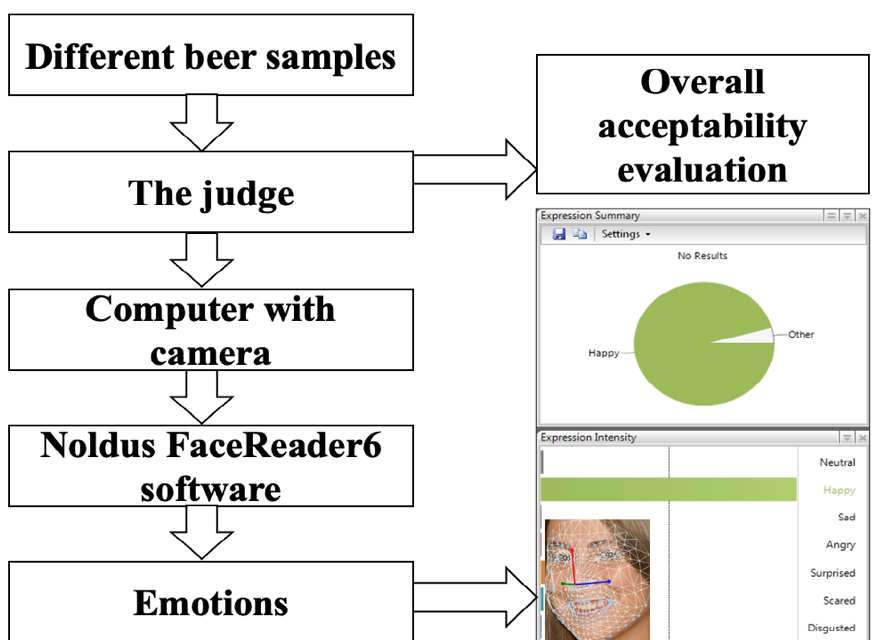
Figure 2. Analysis of the emotions induced by the beer using FaceReader 6 software (Noldus Information Technology, Wageningen, The Netherlands), and further scoring the eight emotion patterns: neutral, happy, sad, angry, surprised, scared, disgusted and contempt.